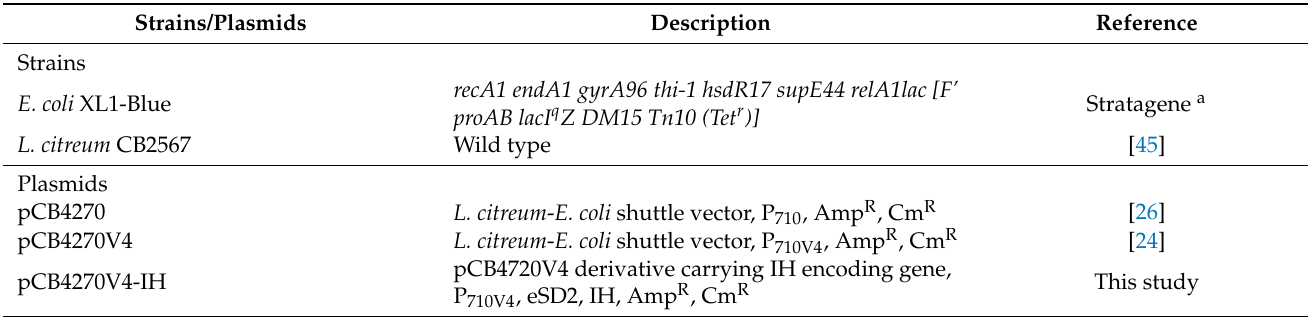
Table 3. List of strains and plasmids used in this study.